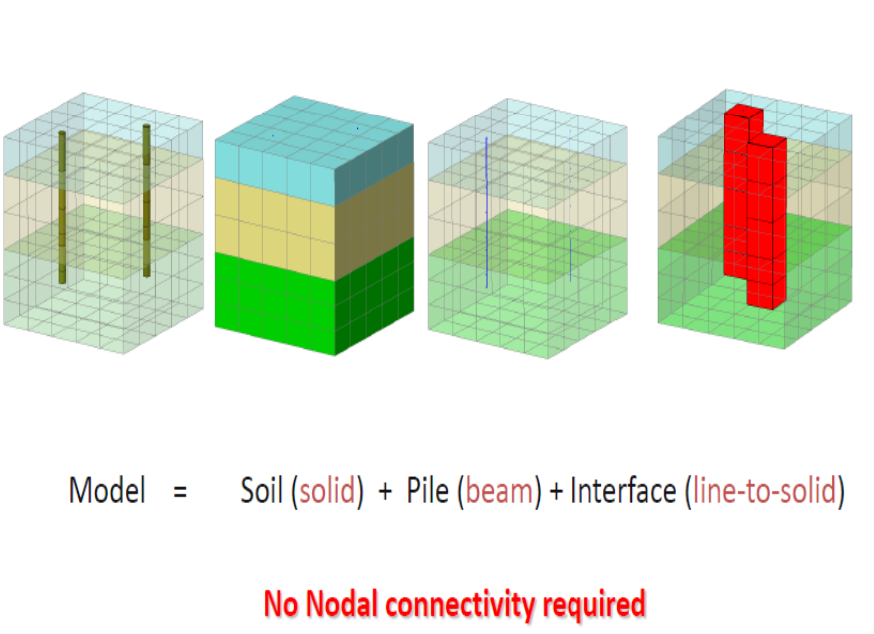
Fig. 7. Shcematic of 3D model of piles with embedded piles or line to solid interface [20].